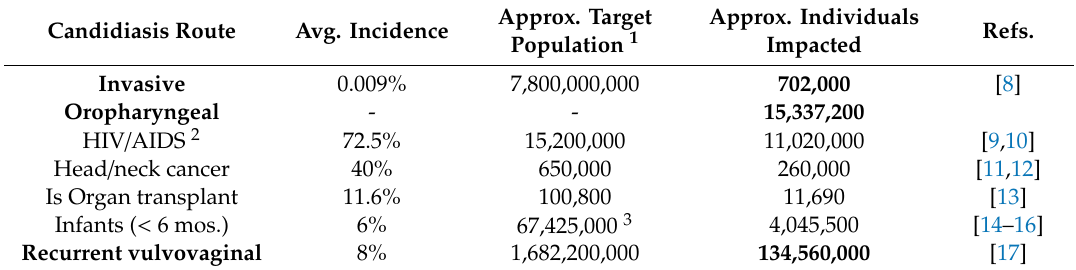
Table 1. Estimated annual global incidence of